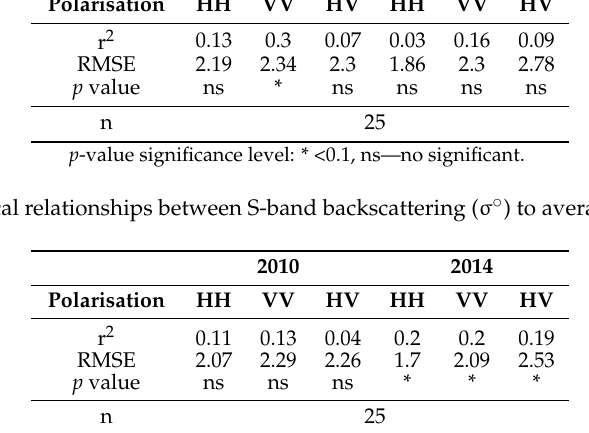
Table 6. Statistical relationships between S-band backscattering ( σ °) to stand number density. 2010 Polarisation